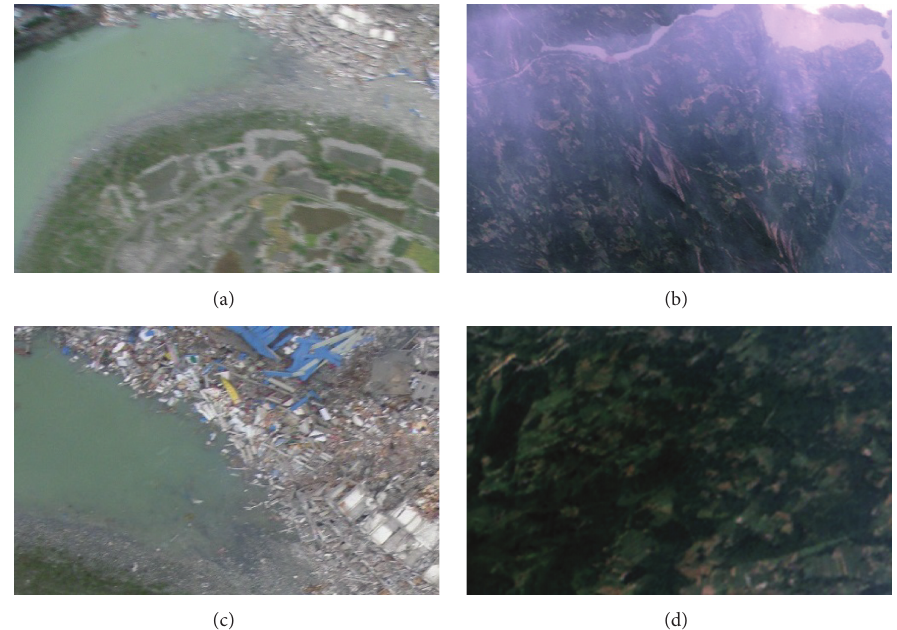
Figure 4: The qualified and the unqualified aerial image samples captured by a UAV system.